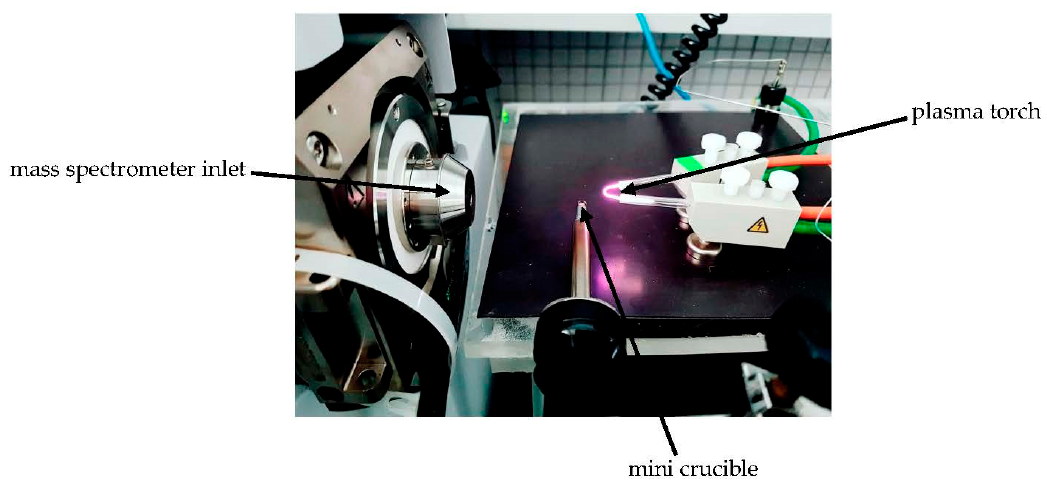
Figure 1. The flowing atmospheric ‐ pressure afterglow (FAPA) ‐ MS measuring system.